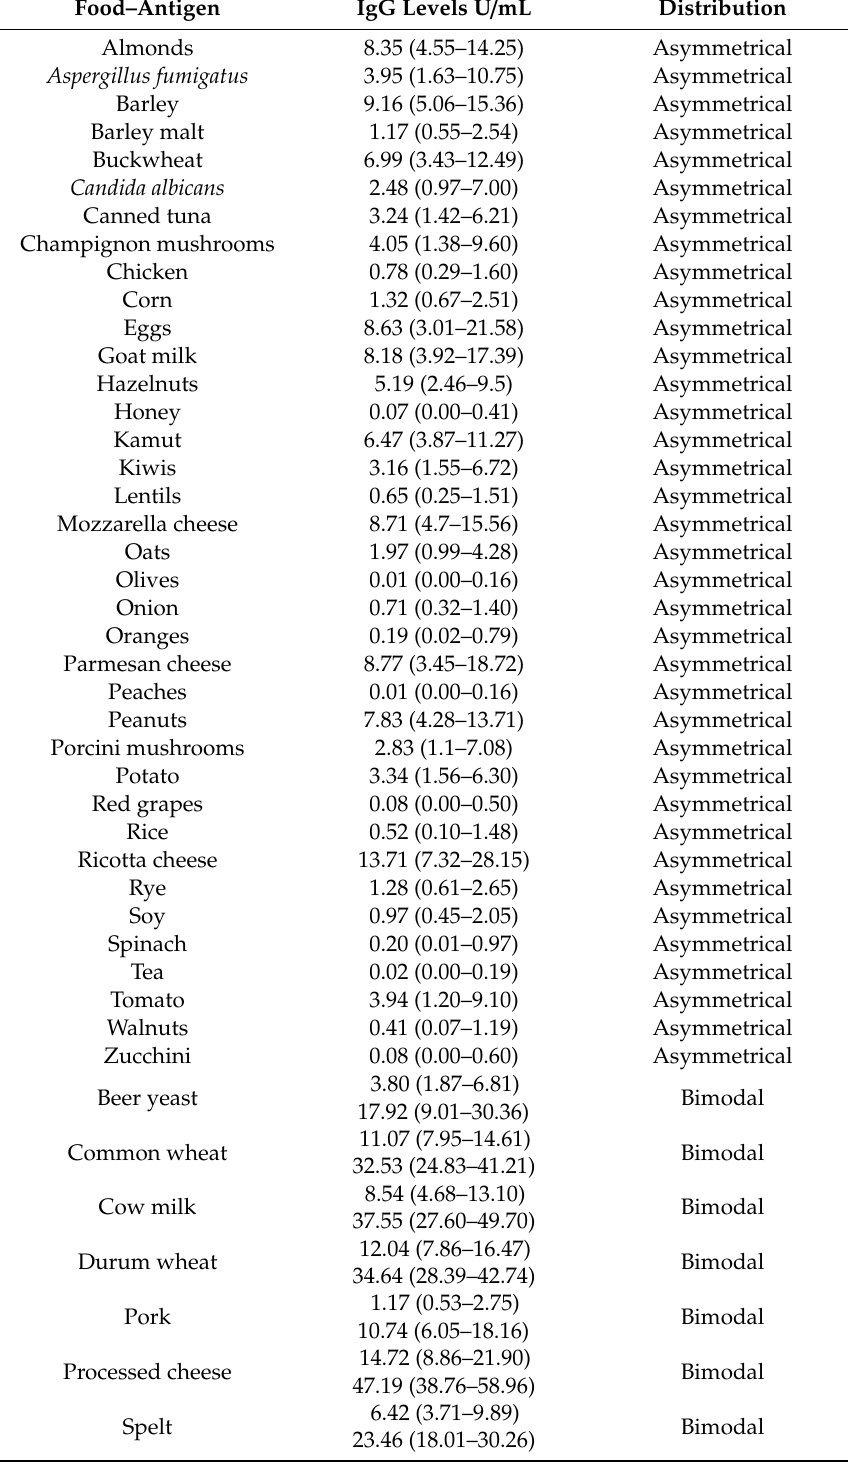
Table 1. List of tested foods, median and interquartile range of corresponding immunoglobulin G (IgG) values, and type of frequency distribution. For food-related IgG with a bimodal distribution, the interquartile range of both modes is